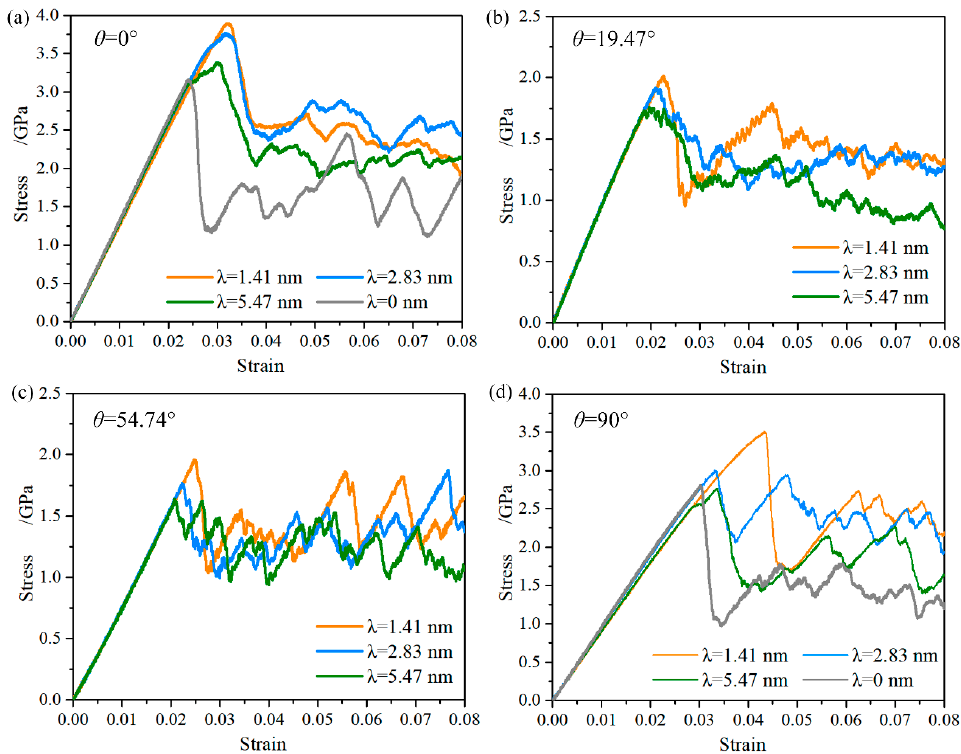
Figure 2. Engineering stress-strain curves of the NT Au nanowires with ( a ) θ = 0°, ( b ) θ = 20°, ( c ) θ = 54°, and ( d ) θ = 90° in the strain range of 0 to 0.05.